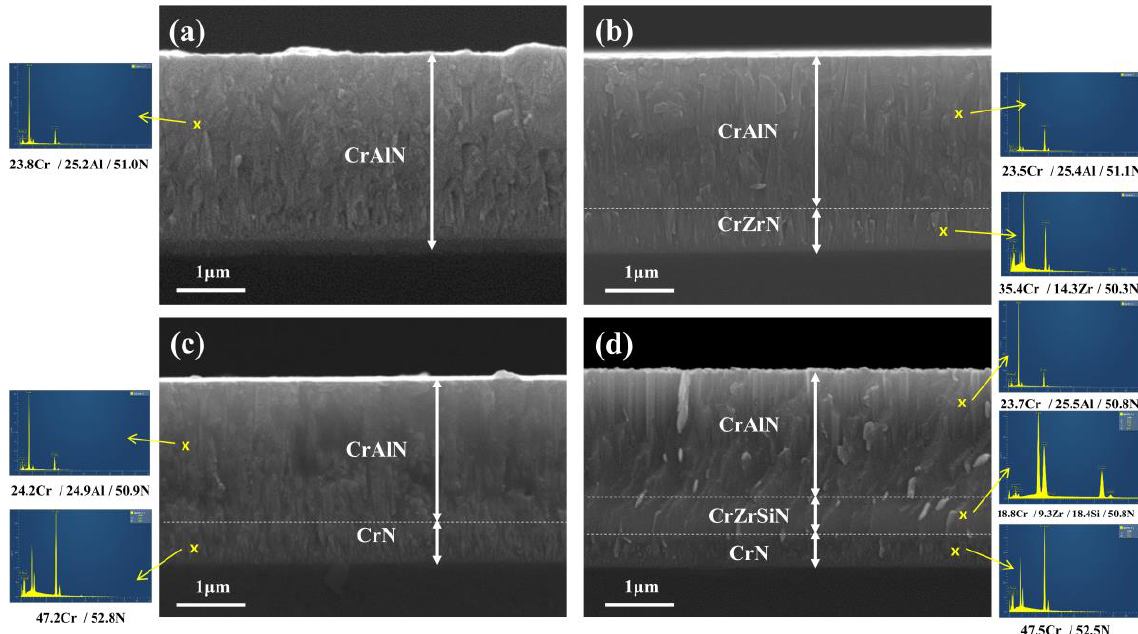
Figure 1. Cross-sectional images of the CrAlN coatings with ( a ) no interlayer, ( b ) CrZrN interlayer, ( c ) CrN interlayer, and ( d ) CrN/CrZrN interlayer.